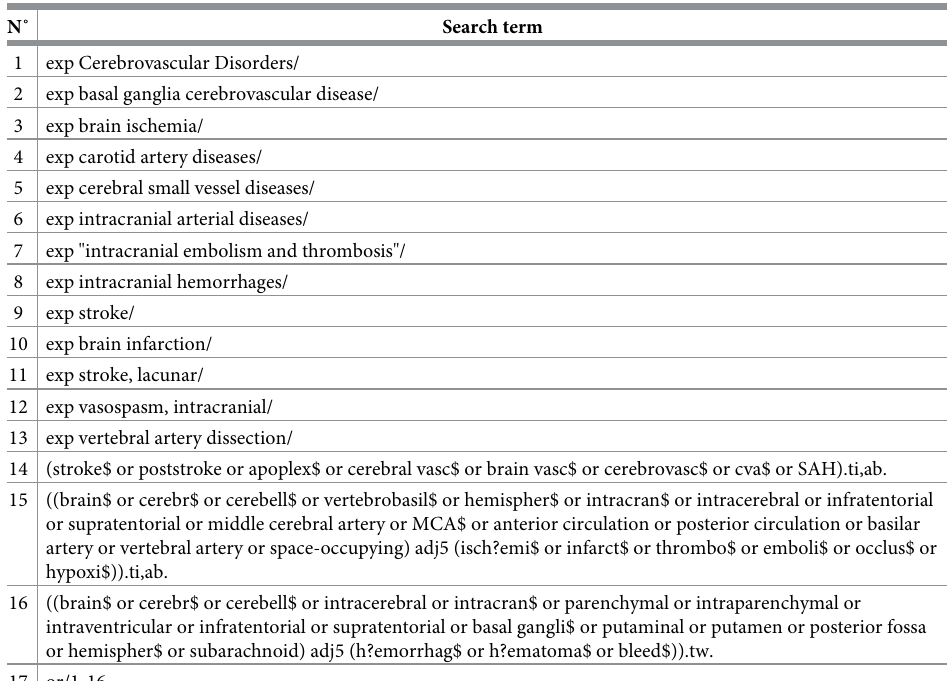
Table 1. Search strategy for MEDLINE using the Ovid